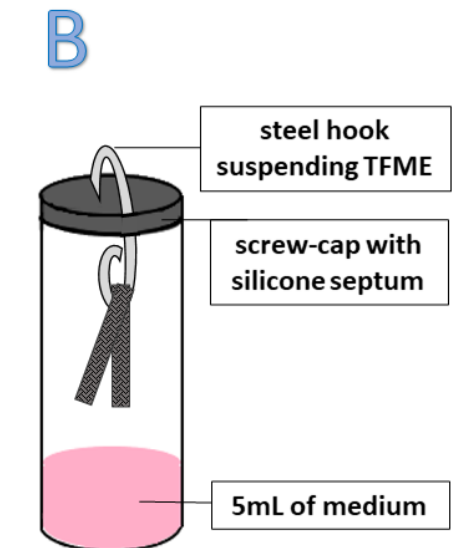
Figure 6. Modes of headspace sampling: ( A ) External headspace where TFME mesh was placed inside a sorption glass tube exposed to the sample via a 1/4 ″ Teflon tube (flushed five times bidirectionaly prior to extraction), ( B ) Internal headspace, where TFME mesh was suspended on a steel hook inside the tightly closed 20 mL glass vial containing 5 mL of liquid sample.